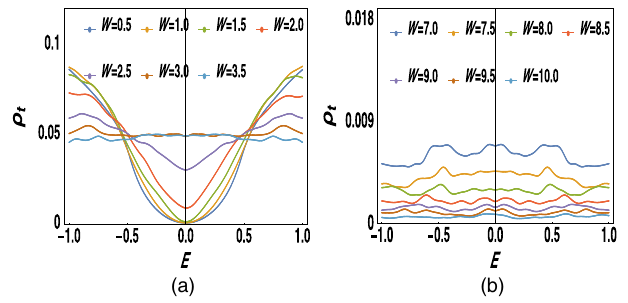
E Þ ] versus t ð E Þ ∼ j E j t ð 0 Þ is t ð E Þ versus t ð